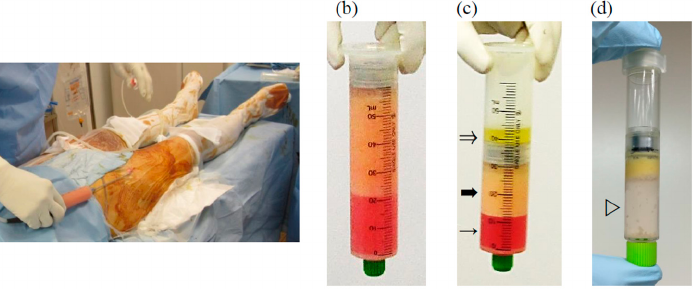
Figure 5. Preparation of adipose-derived extract (AE) ( a ) Liposuction from the donor’s thigh. ( b ) Lipoaspirate before centrifugation. ( c ) Adipose tissue after centrifugation separated into three fractions: oil ( ⇒ ), adipose tissue ( ➡ ), fluid ( → ) ( d ) AE ( ▷ ) obtained as the aqueous fraction .